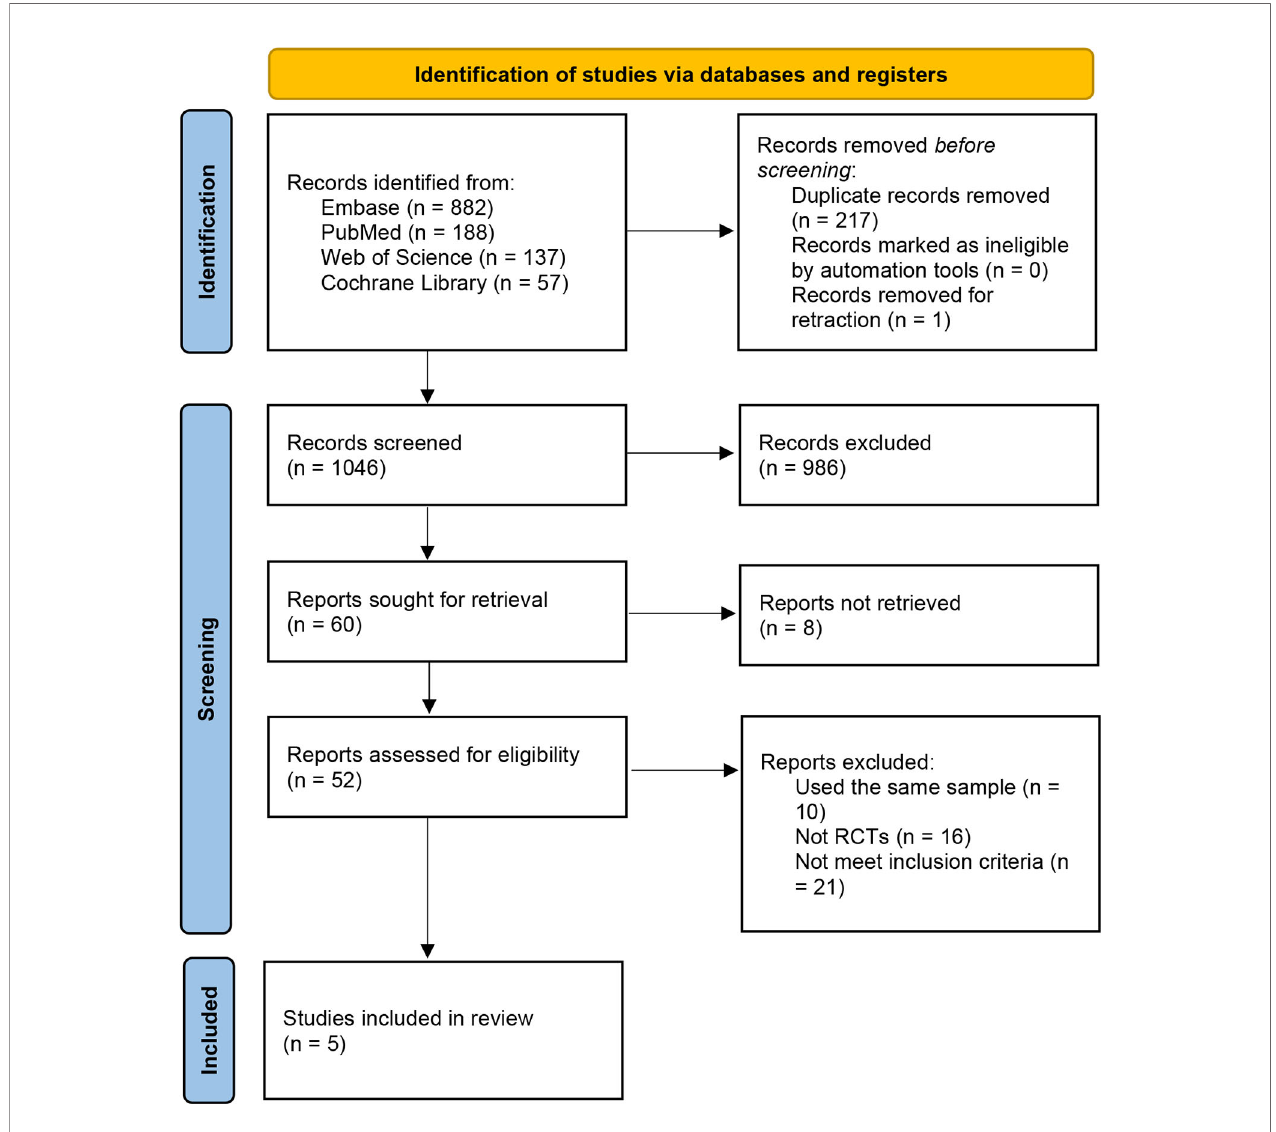
FIGURE 1 | PRISMA fl ow